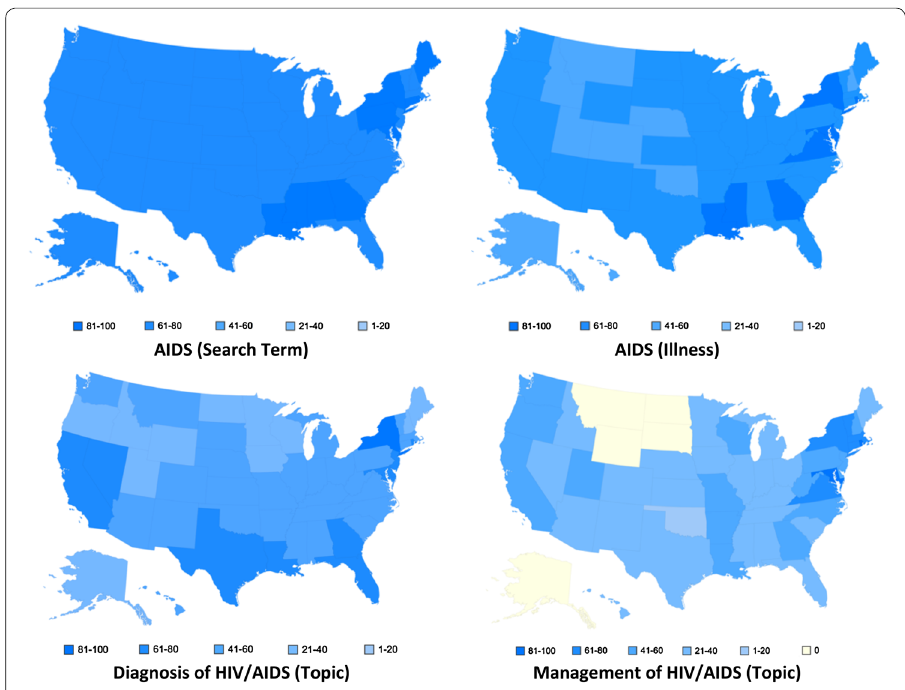
Fig. 3 Online Interest by State for ‘AIDS (Search Term)’, ‘AIDS (Illness)’, ‘Diagnosis of HIV/AIDS (Topic)’, and ‘Management of HIV/AIDS (Topic)’ from January 2004 to December